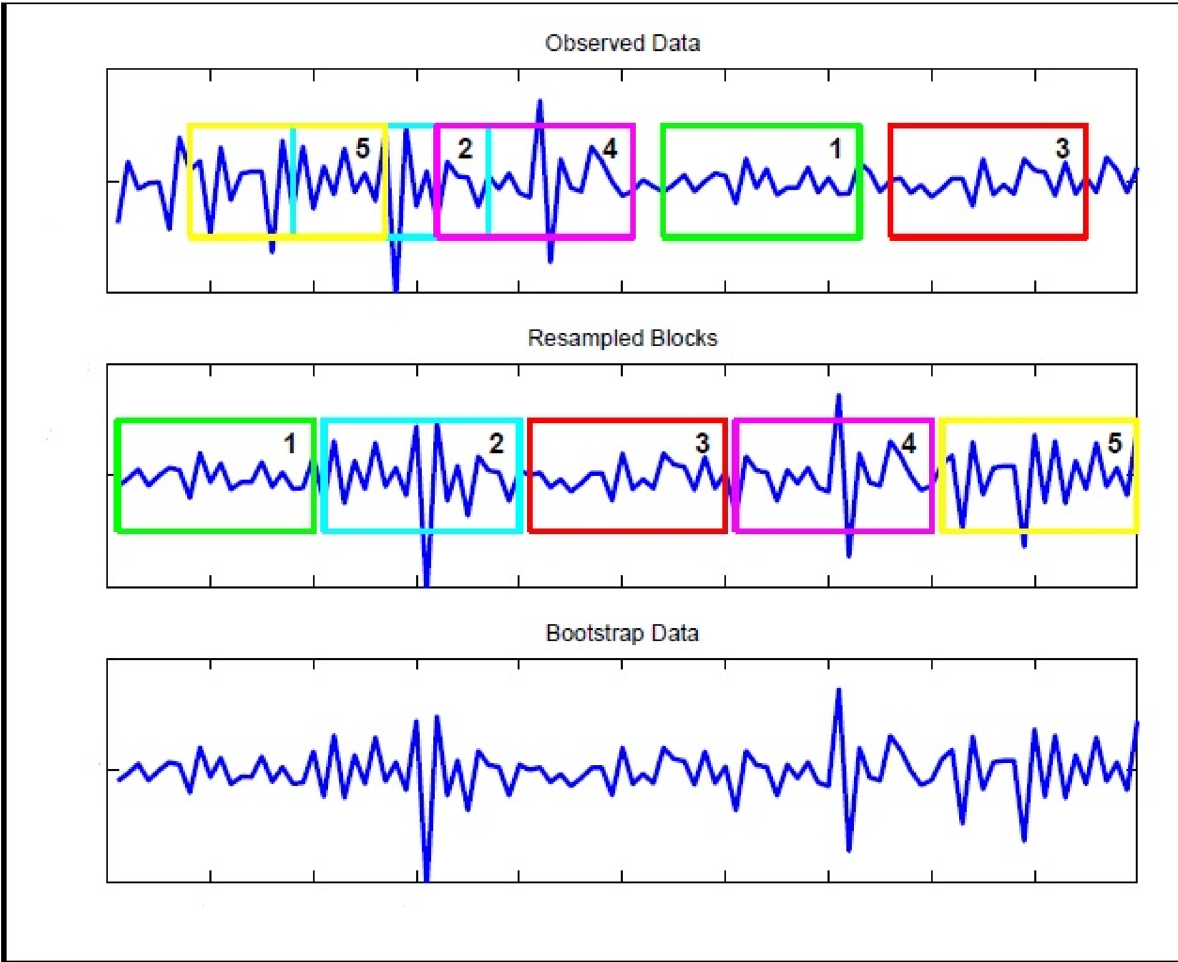
Fig 2. Graph of the moving block bootstrap principle. Graph showing the principal of moving block bootstrap. The moving block bootstrap randomly selects blocks of the original data (top) and concatenate them together (center) to form a resample